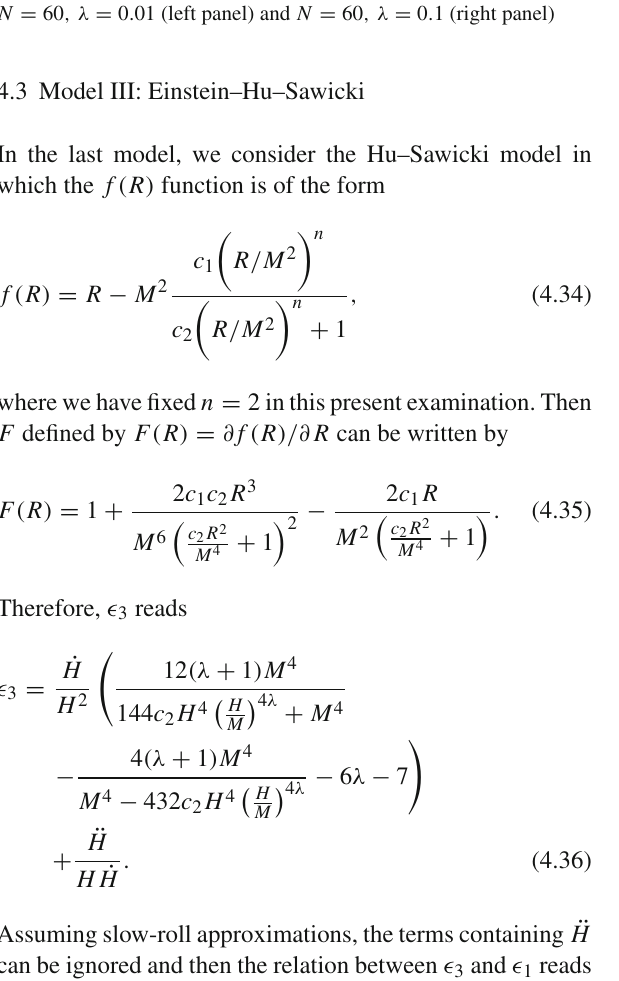
Fig. 6 Figures show the behavior of (cid:23) (cid:25) against α and β given by Eq. (4.33). A vertical axis represents values of (cid:23) (cid:25) . For the plots we have used N = 60 , λ = 0 . 01 (left panel) and N = 60 , λ = 0 . 1 (right